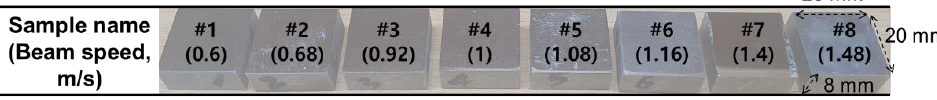
Figure 1. Varying LBS conditions applied to the test samples and their